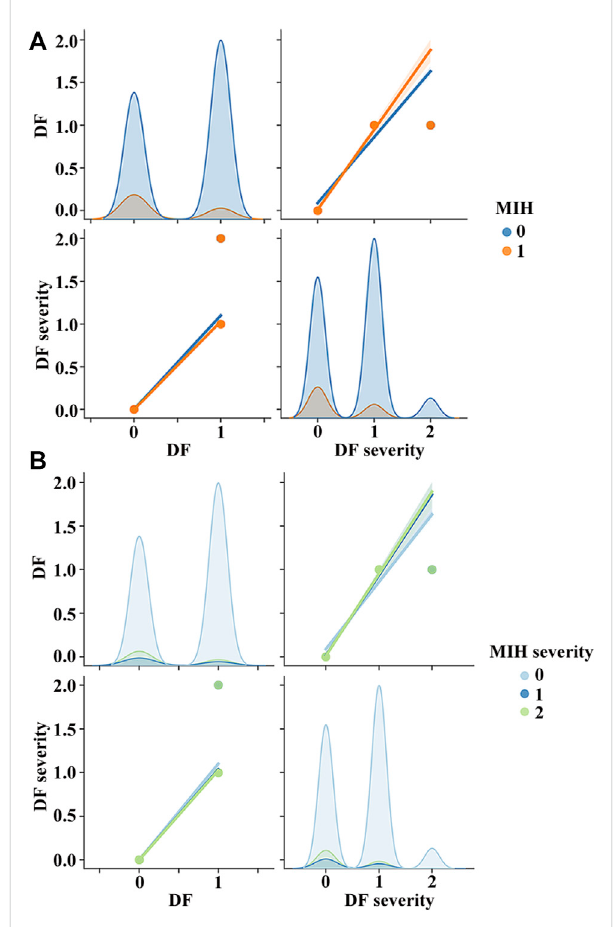
FIGURE 6 Pair plot was used to show relations among MIH, MIH severity, DF, and DF severity. During data preprocessing, the diagnoses of MIH or non-MIH, as well as DF or non-DF, were encoded using a binary encoder as 0 and 1. Thus, MIH or DF became 1, and non-MIH or non-DF became 0. Depending on the severity of MIH or DF, the level of MIH or DF was classed as normal (0), mild (1), or severe (2). (A) MIH wasstronglynegativelycorrelatedwithDFandDFseverity. (B) Severity of MIH was reduced, followedby the incidence of DFand thestrength of DF